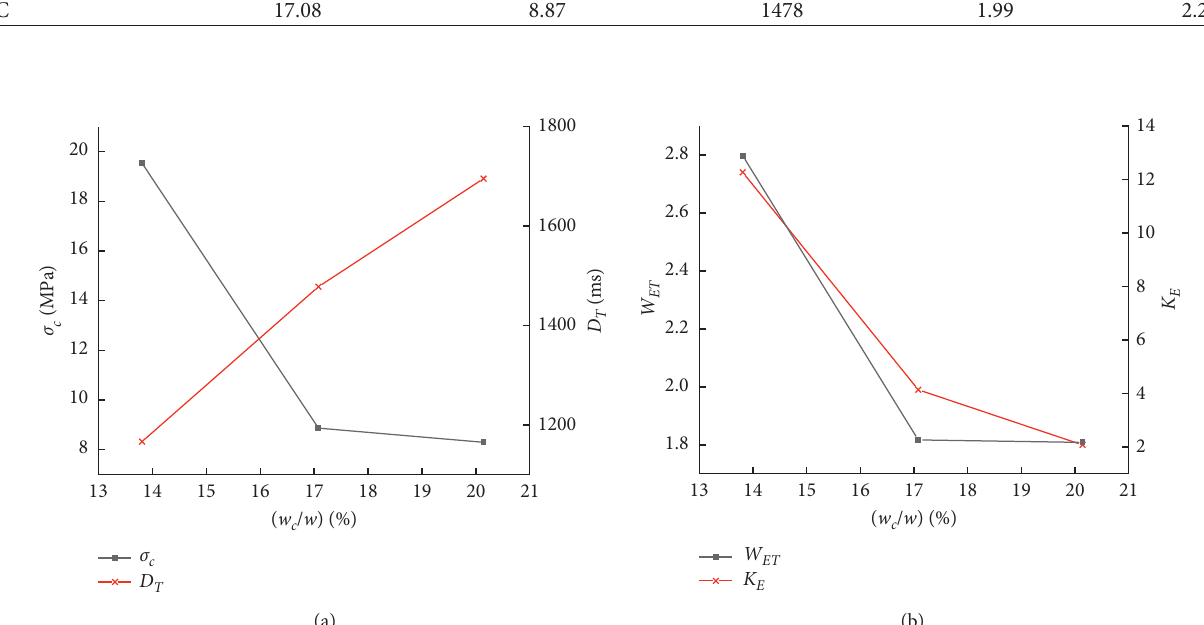
Figure 8: Relationship between fracture strain energy and burst tendency